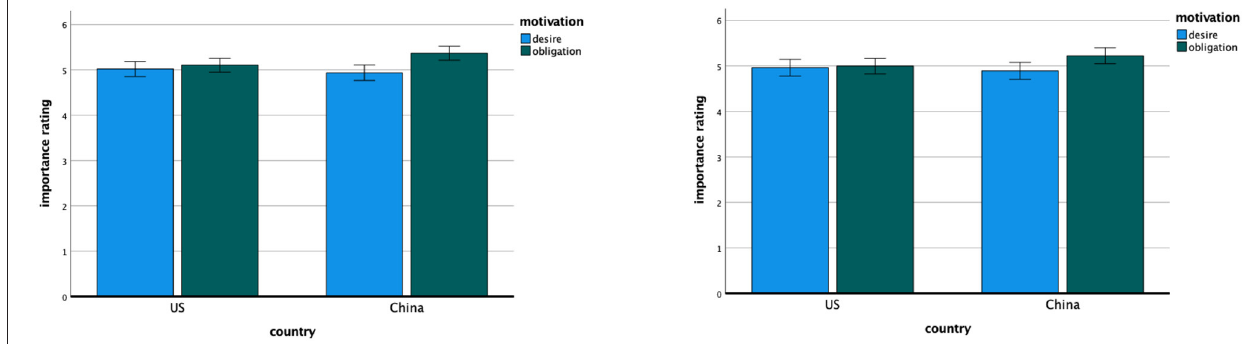
relative to the obligation to the community was greater among the United States participants than among the Chinese